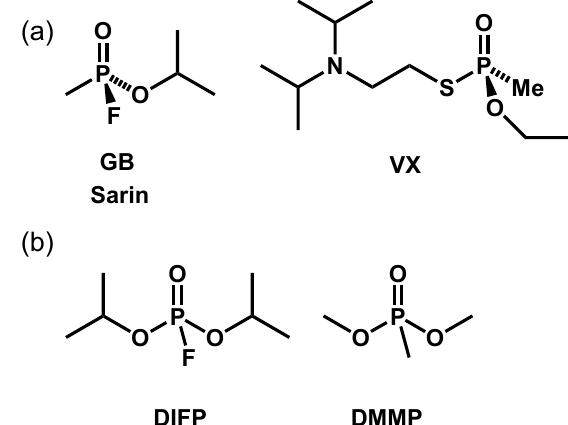
Figure 1. Examples of ( a ) highly toxic organophosphonate nerve agents and ( b ) nerve agent models of lower toxicity, used in conventional laboratories. DIFP: diisopropylfluorophosphate. DMMP: dimethylmethylphosphonate. GB: Sarin.